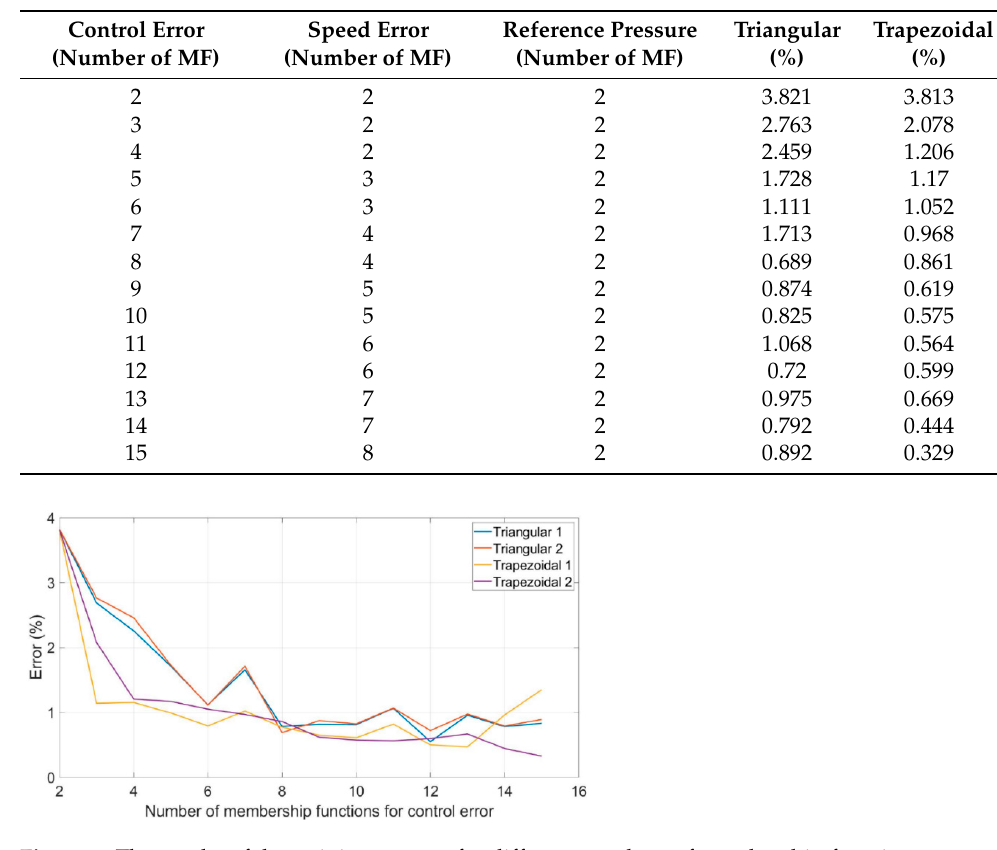
Table 2. Results from the training process—set 2.